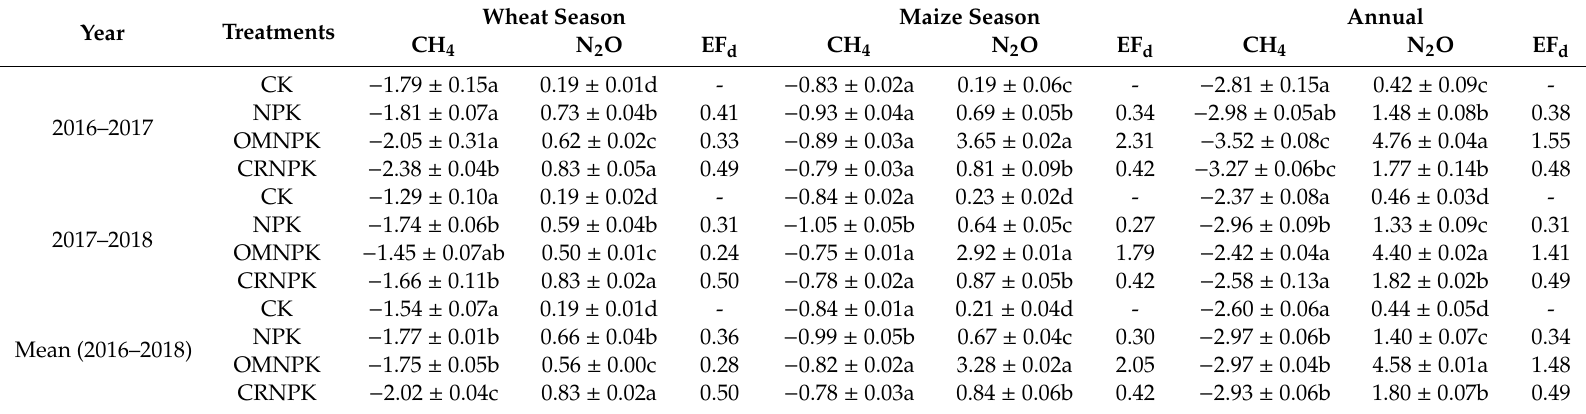
Table 1. Seasonal and annual cumulative fluxes of methane (CH 4 , kg · C · ha − 1 ), nitrous oxide (N 2 O, kg · N · ha − 1 ), and direct emission factors (EF d , %) for the four treatments over the two-year period from